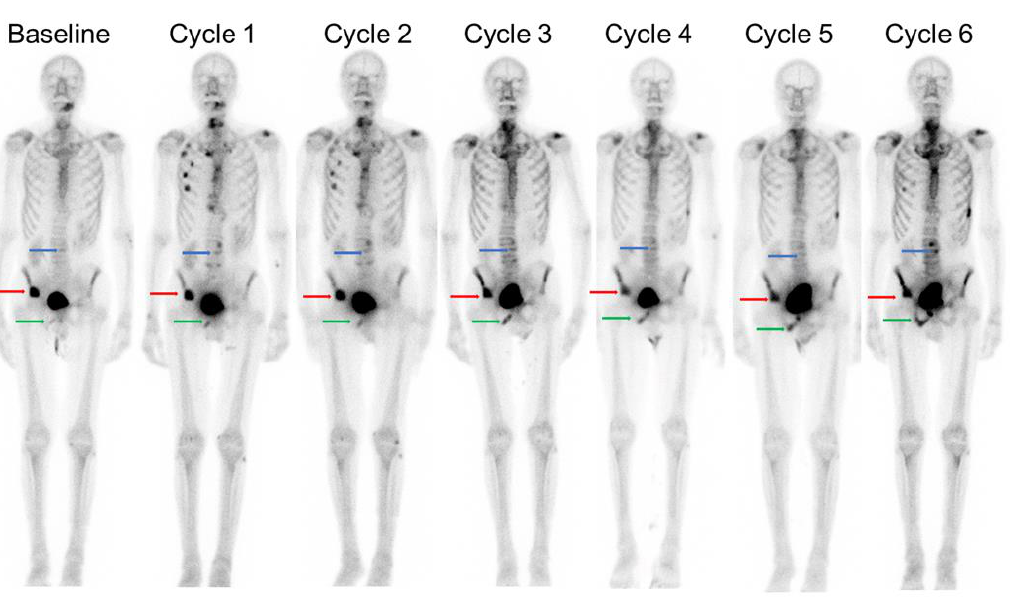
Figure 1. 99m Tc MDP bone scintigraphy evaluation of 223 RaCl 2 therapy. Gleason score 4 + 3 = 7 prostate cancer undergoing serial 99m Tc methylene diphosphonate (MDP) bone scans and with known osseous metastatic deposits (arrows) during treatment with 6 cycles of 223 RaCl. Patient is concurrently maintained on Lupron, and bone protective therapy with abiraterone and prednisone. At baseline prior to 223 RaCl 2 , he was treated with oxycodone for pain control and had a baseline PSA of 10.9 ng/mL. Lack of quantitative measurements limits the standard planar evaluation of response to therapy. Serial MDP bone scintigraphy demonstrated some improvement in the right iliac metastatic deposit (red arrow) with 223 RaCl therapy but progressive disease in the right inferior pubic ramus (green arrow) and lumbar spine (blue arrow). Note right sided post traumatic rib fractures at cycle 1 and cycle 2.